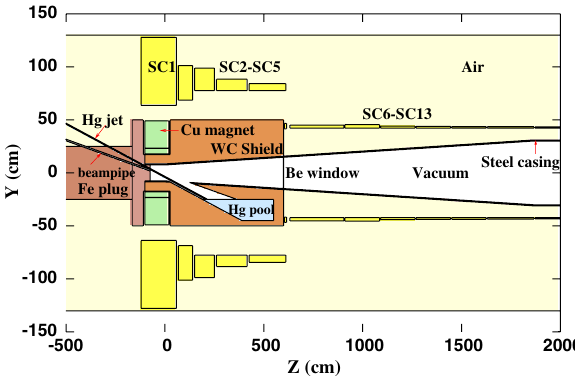
FIG. 1. Schematic of the Study 2 geometry of the Neutrino Factory target system. The shielding is comprised of tungsten carbide (80%) with water cooling (20%). The superconducting magnets are labeled SC n , where n ¼ 1